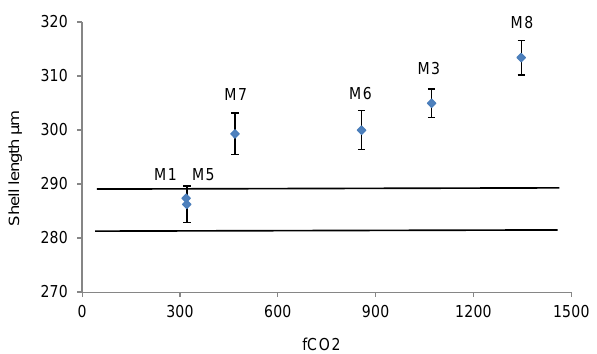
Figure 3. Larval sizes in different f CO 2 levels on day 10. Data are presented as means ± SE; n = ca. 70 individuals. The horizontal lines indicate the range of average larval sizes on day 0.